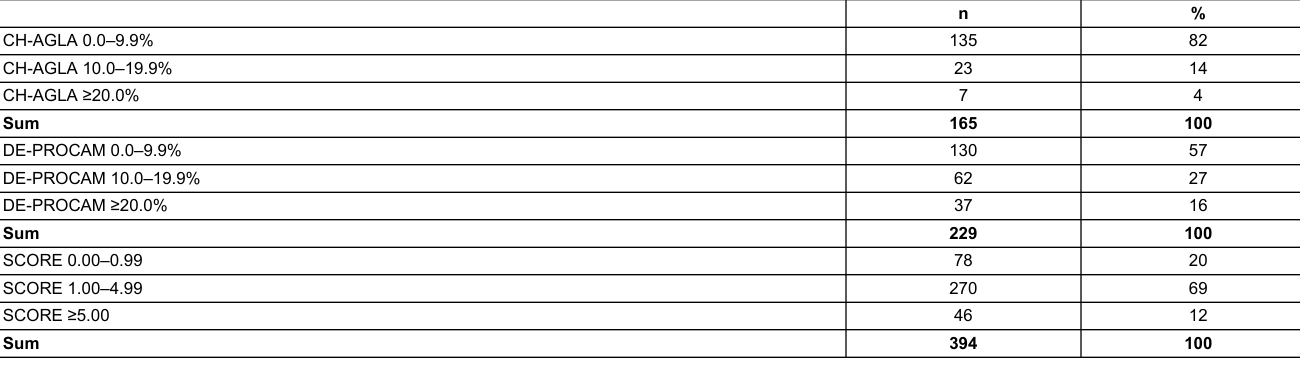
Table 2: Frequency distribution of VA70 among risk